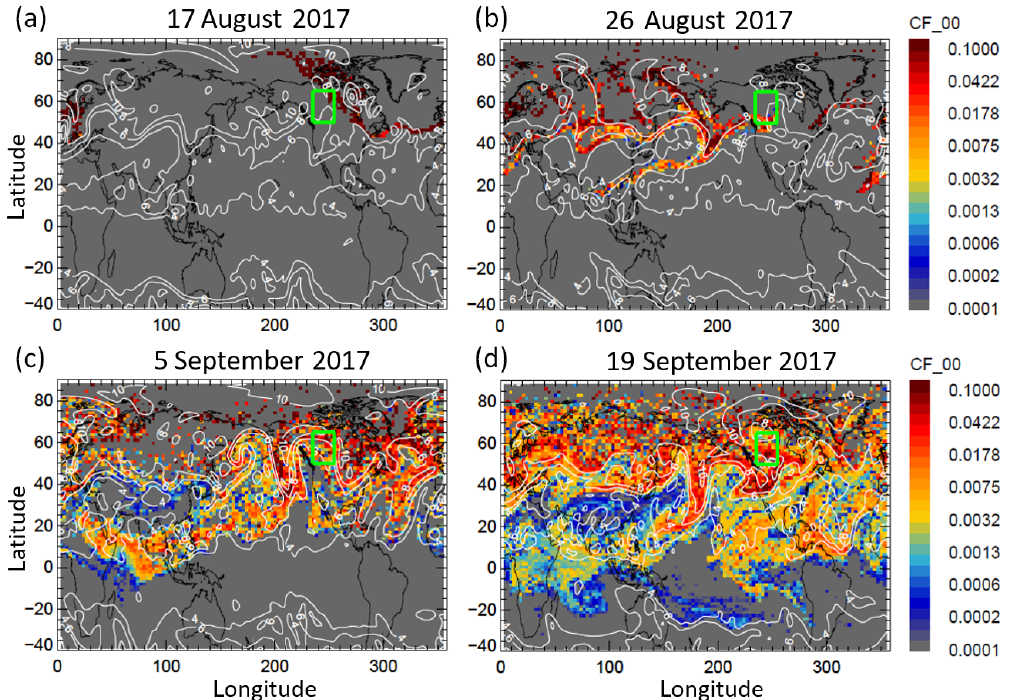
Figure 3. Selected maps at 380K potential temperature on (a) 17 August, (b) 26 August, (c) 5 September and (d) 19 September at 380K for the CLaMS simulation for the fire tracer initialized in the green box (area: 50 < lat < 65, 235 < long < 255; potential temperature: 345K < θ < 465K) between 345 and 465K potential temperature. CF_00 represents the fraction of the air mass originating from the green box. The position and time (12 to 14 August 2017) of the initialization of the fire tracer have been chosen according to the first appearance of enhanced CO mixing ratios in the stratosphere above western Canada, observed by IASI (as shown in Fig. 4). White lines represent PV contours. This approach is similar to the one presented in Vogel et al. (2015).